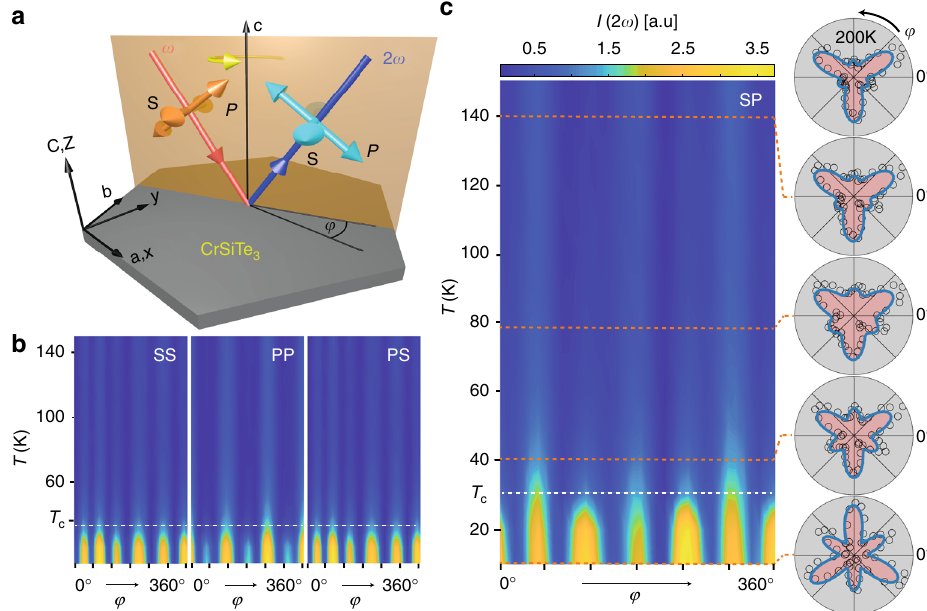
Fig. 2 Temperature dependence of the SHG rotational anisotropy. a Experimental geometry of the RA SHG experiment. The φ = 0° direction coincides with the crystallographic a -axis. b Image plots of the raw temperature dependent RA SHG data acquired in SS, PP, and PS polarization con fi gurations, where the fi rst and second labels denote the selected incident ( ω ) and detected (2 ω ) polarization components. The horizontal black line indicates the T (see Fig. 1). c A zoom-in on the RA SHG image plot acquired in SP con fi guration. Cuts at select temperatures displayed as polar plots (open circles) are shown to emphasize the changes in shape of the RA patterns taking place above T c . Blue curves are best fi ts to the expected EQ SHG response from a (cid:1) 3 point group as described in the